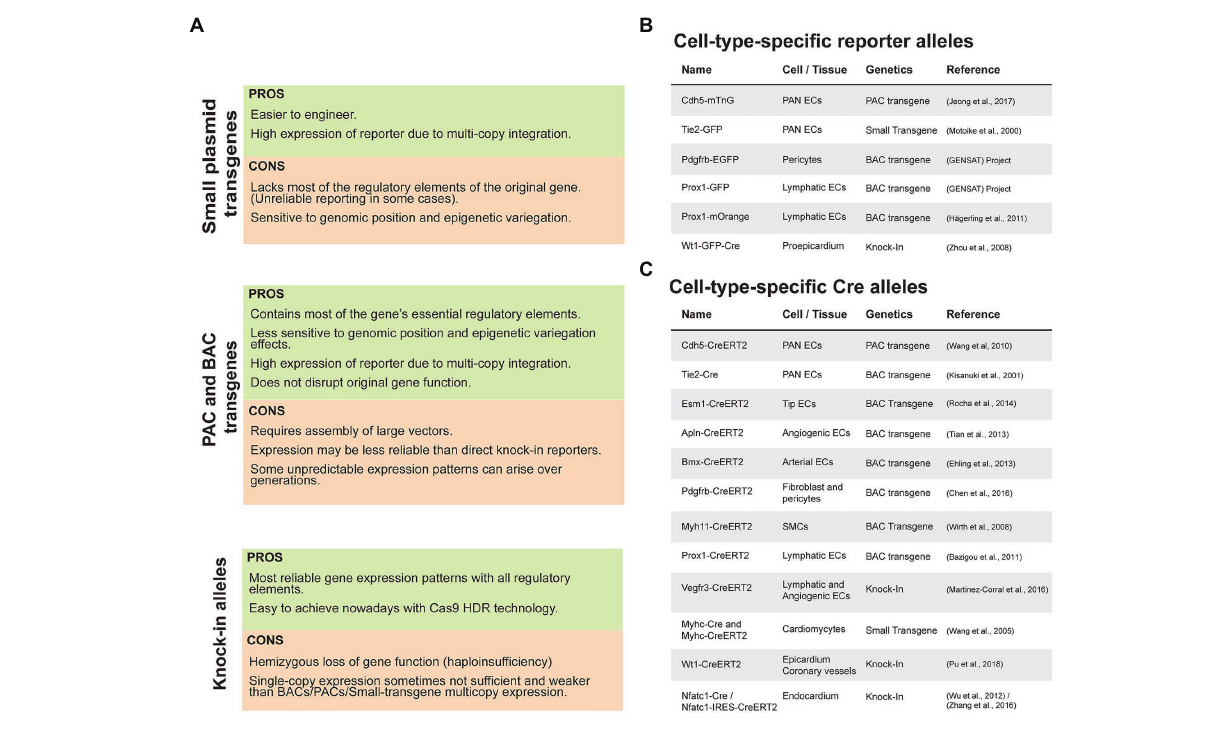
FIGURE 1 | Pros and Cons of transgenic and knock-in lines used in the cardiovascular biology field. (A) Summary of advantages and disadvantages of different types of transgenic and knock-in alleles. (B) List of commonly used fluorescent reporter mouse lines in the cardiovascular biology field. (C) List of commonly used Cre/CreERT2 mouse